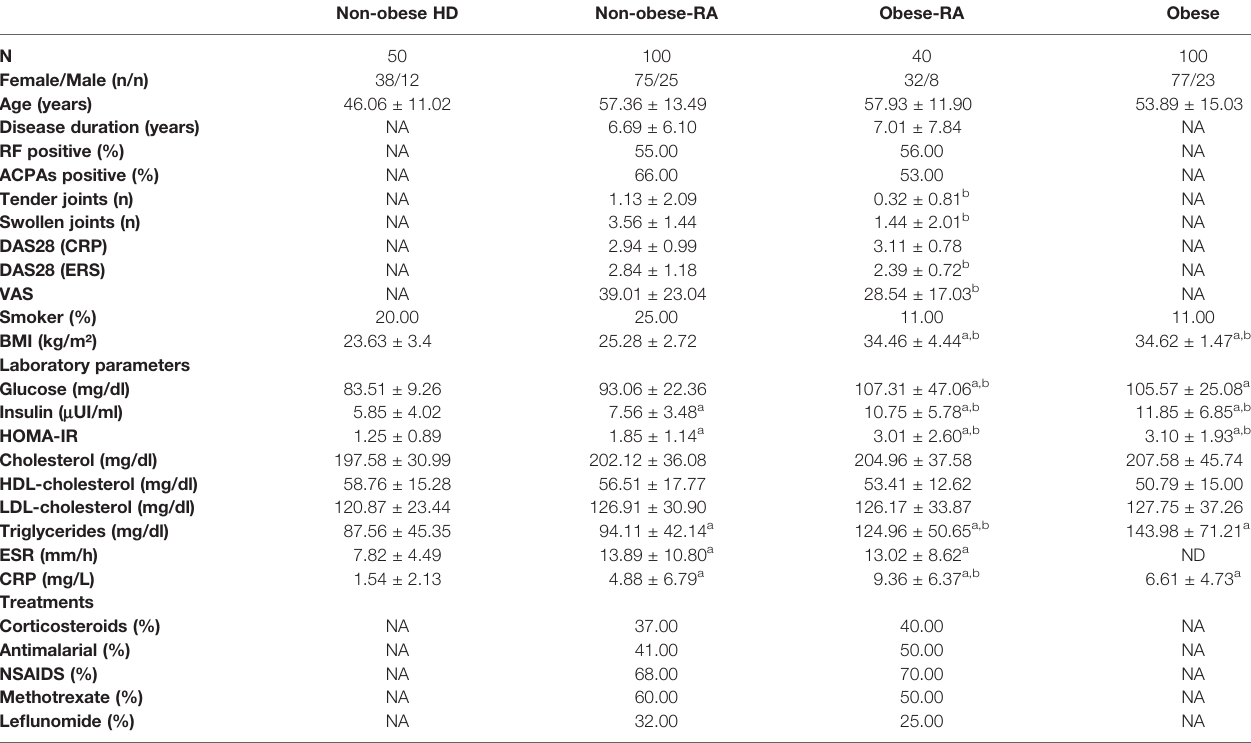
TABLE 1 | Clinical details of the four cohorts included in the study: RA-non-obese patients, RA-obese patients, healthy donors, and obese non-RA subjects. Non-obese